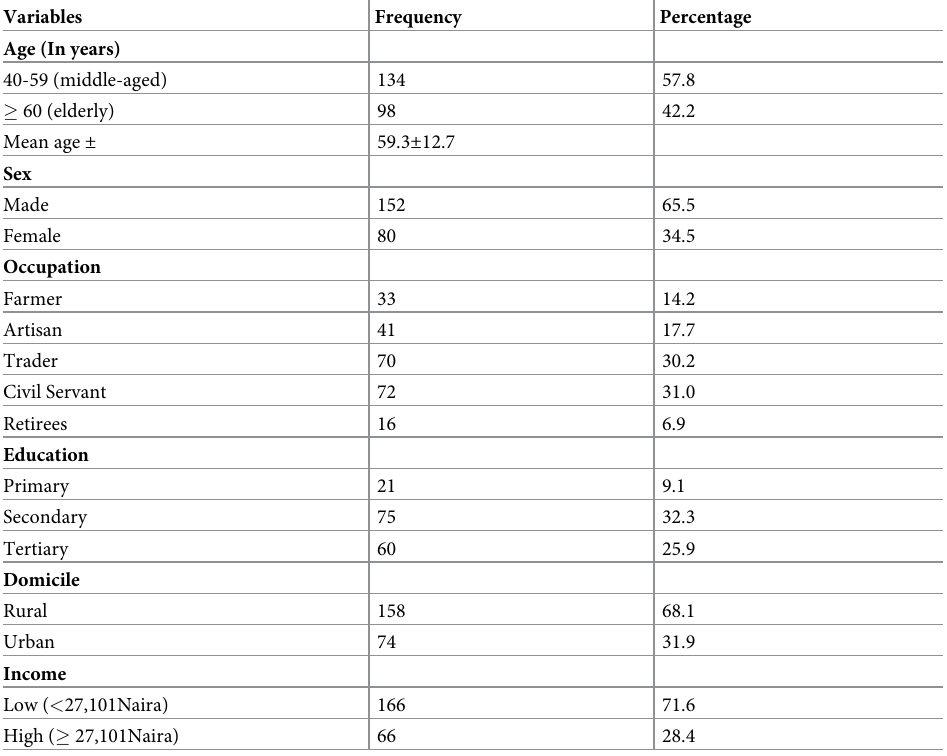
Table 1. Socio-demographic characteristics of respondents